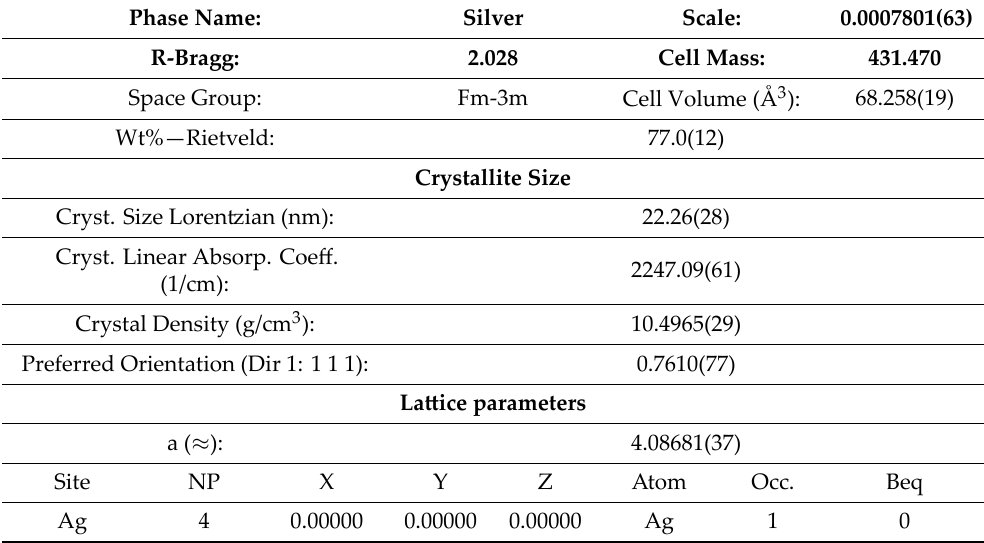
Table 3. Rietveld refinement of silver